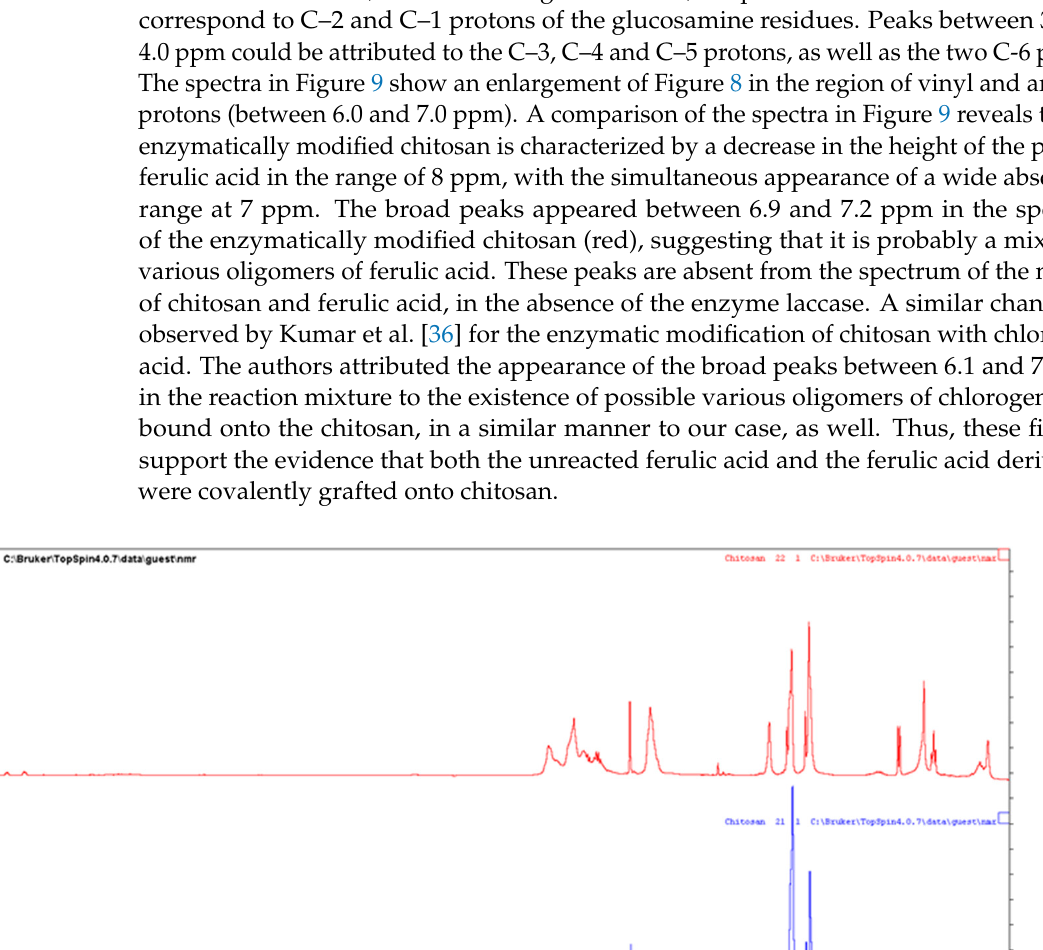
16 of 23 Figure 7. SEM micrographs of the surfaces of films based on CS ( a ), FA-CS derivative ( b ), CS–GEL ( c ), CS–GEL-FA derivative ( d ), CMC ( e ) and CMC-FA-derivative ( f ) films. 3.6.4. Nuclear Magnetic Resonance (NMR) Spectroscopy In order to support the evidence that chitosan was successfully modified, we also applied 1 H-NMR. For this reason, untreated and enzymatically modified chitosan solu-